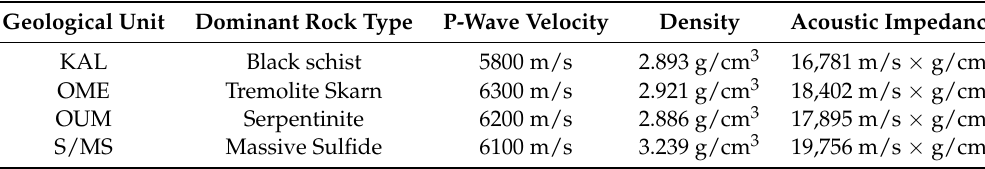
Figure 6. Vertical sections through geological and petrophysical models used for seismic forward modeling study. ( a ) Model of the larger geological domains that were used to define the P-wave velocities. ( b ) Kriging interpolated density model obtained from specific gravity measurements of borehole core logs. ( c ) Acoustic impedance model calculated from the P-wave velocity model ( a ) and density model ( b ). Table 2. Overview of geological and petrophysical parameters used for seismic forward modeling. Density and acoustic impedance values represent the mean average values within the respective geological units. More detailed explanations are given in the